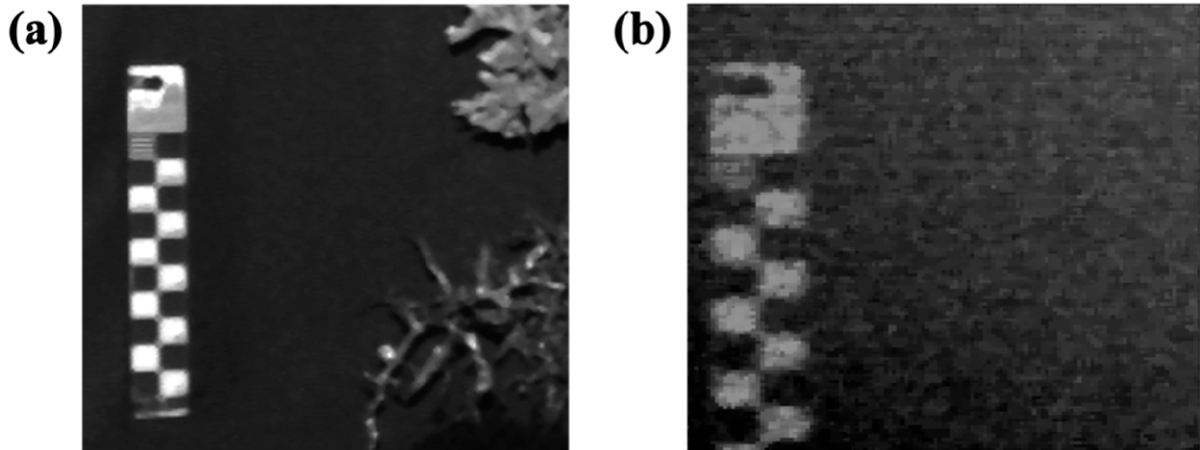
Figure 9. Fluorescent scale for resolution verification. White and black squares represent 10 mm segments. In the left image ( a ), the white and black lines visible in the upper left square represent 1.0 mm markings from 490 excitation and 490 emission (i.e., elastic), and in the right image ( b